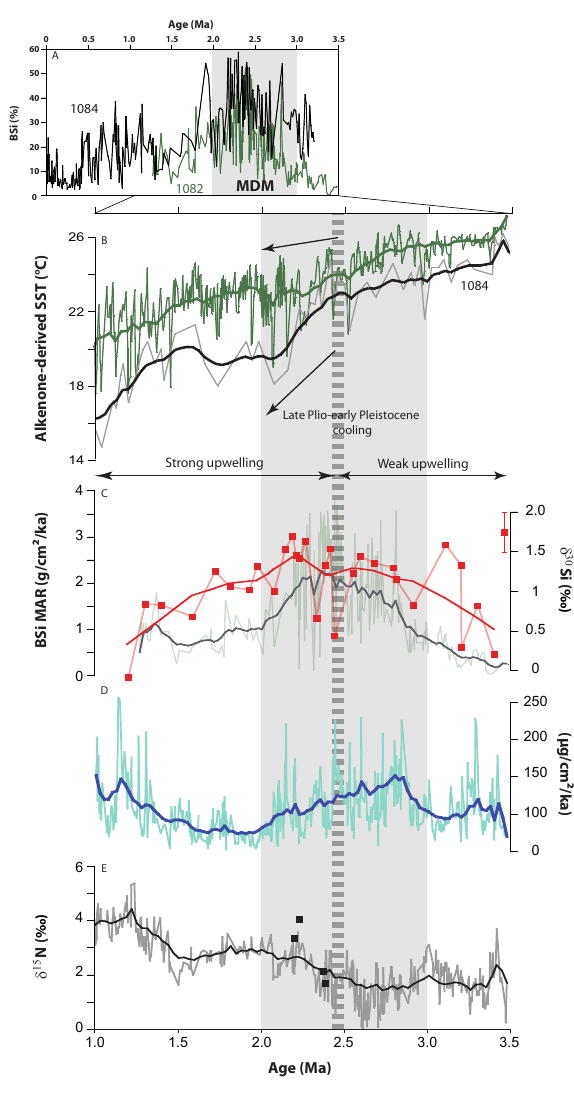
Fig. 3. (A) BSi content (%) at the Benguela Sites 1082 (green) and 1084 (black) (Etourneau et al., 2009; Lange et al., 1999; P´erez et al., 2001; Robinson and Meyers, 2002). (B) Alkenone-derived SST records at Sites 1082 (green) (Etourneau et al., 2009) and 1084 (black) (Marlow et al., 2000). (C) δ 30 Si (‰) (red) (this study) and BSi mass accumulation rate (MAR) (gcm − 2 ka − 1 ) (light green) (Etourneau et al., 2009). (D) Alkenone MAR record (blue) (Etourneau et al., 2009). (E) Bulk δ 15 N (black) (Etourneau et al., 2009) and diatom-bound δ 15 N (black squares) (Robinson and Meyers, 2002) records at Site 1082. The solid lines for each records corresponds to the smoothed curve. Age models of Sites 1082 and 1084 are described in Etourneau et al. (2009). In panel (B) , the long- term reproducibility of the δ 30 Si measurements is indicated by the error